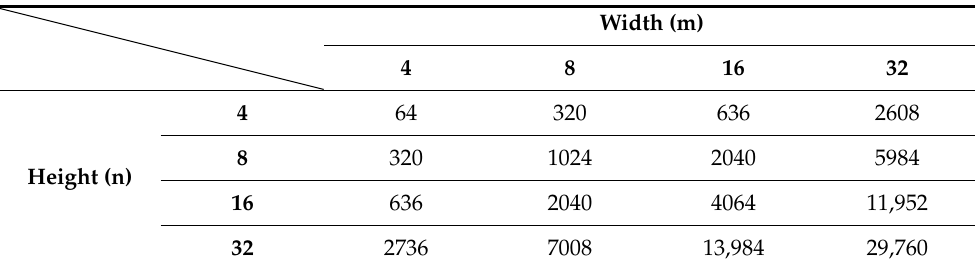
Table 2. Number of multiplications when the horizontal and vertical transforms are a combination of DST-VII and DCT-VIII in the VTM-8.2.